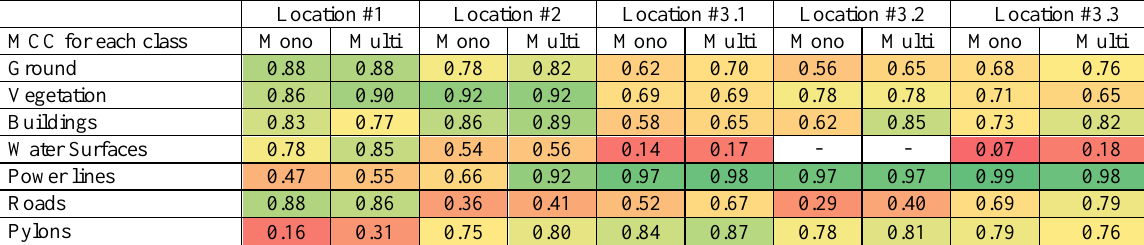
Table 7. MCC value for each class in the